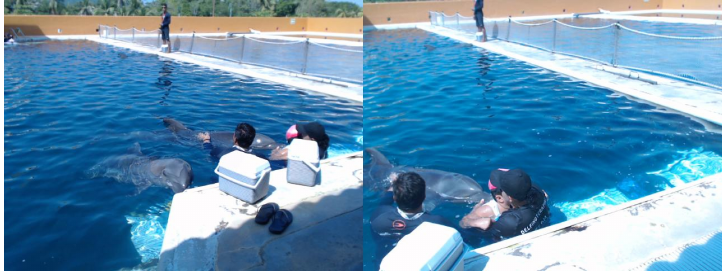
Figure 18. Dolphin-Assisted